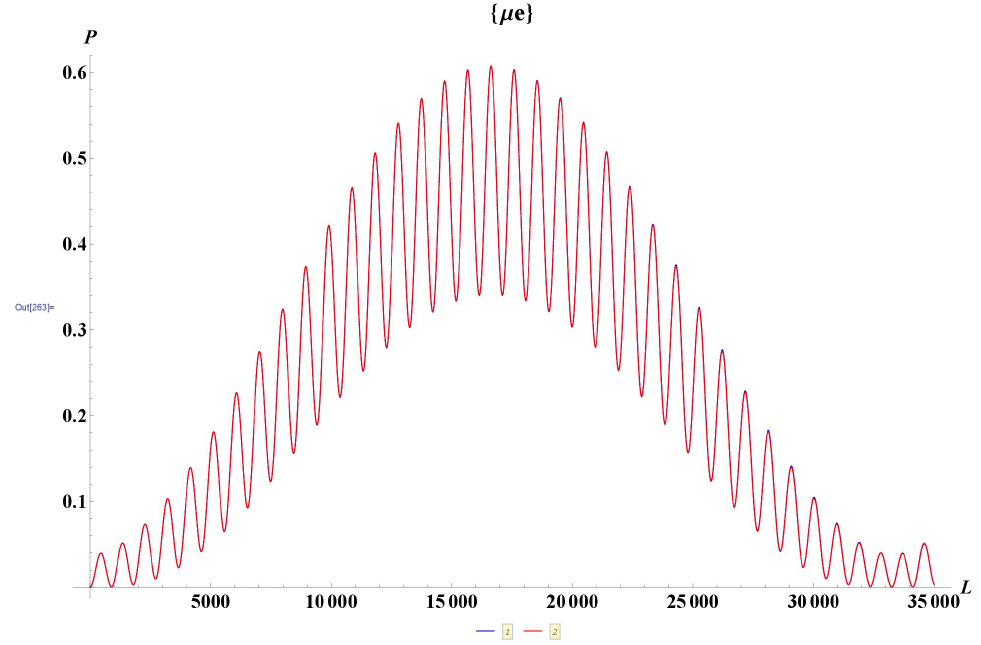
Figure 4. Example of the fact that with Lorentz Invariance Violation (LIV) of parameters δ f kj (cid:39) 10 − 25 for energy beam of E = 1 GeV LIV effects are not visible. Baseline L in km [73]. For lower LIV parameters magnitude effects are visible only for higher energy beam